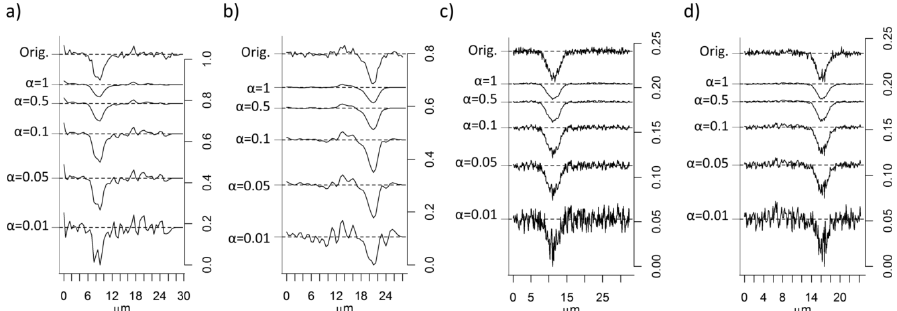
Figure 8. Intensity line scans of score-values from thePC2 score maps in Figure 3c,d after application of the super-resolution algorithm with different α-values at different location in the images where particles are located: ( a ) X = 8.5 µm in PC2 for the 500 nm image; ( b ) Y = 21 µm in the 500 nm image; ( c ) X = 11.5 µm, in the 100 nm image; and ( d ) Y = 16.1 µm in the 100 nm image. The curves are shifted along the ordinate axis for clarity. Table 1. Maximum and minimum derivatives at the inflection points of the peak in the intensity profiles in Figure 8. Image α-value Max. Deriv. Min. Deriv. Image α-value Max. Deriv. Min.Deriv.